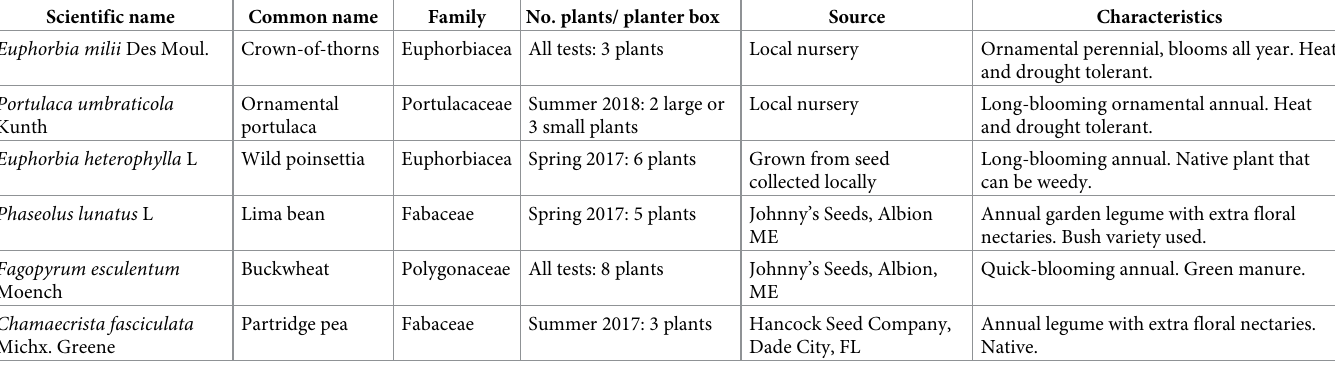
Table 1. Name, planting density, and characteristics of plant species used in the plant mixture